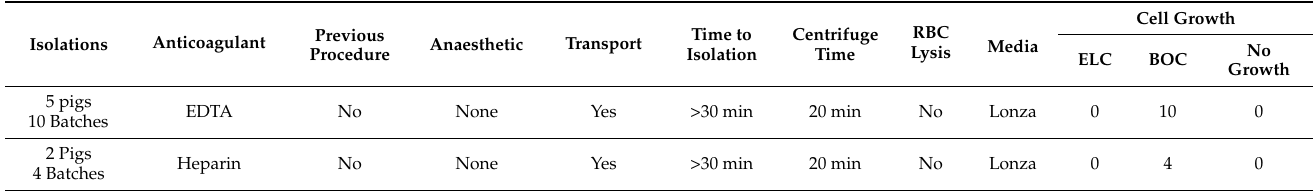
Table 2. Conditions used for isolating blood outgrowth cells from blood collected from pigs at commercial